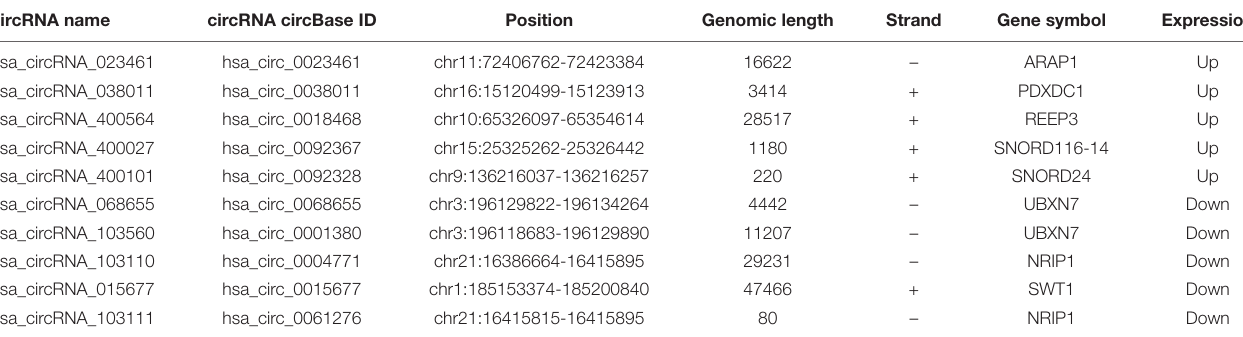
TABLE 3 | The annotation information of the top 5 high-expressed DEcircRNAs and the top 5 low-expressed